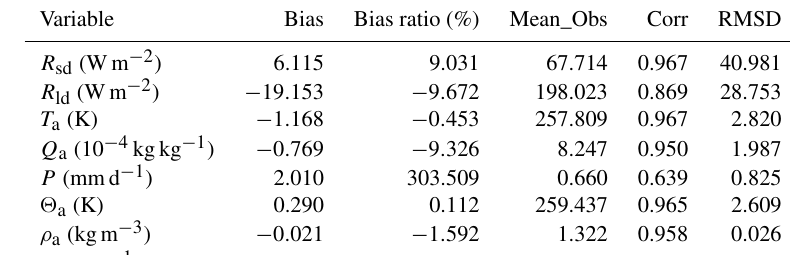
Table 2. Comparison of atmospheric forcing between ERA5 reanalysis and in situ observations.